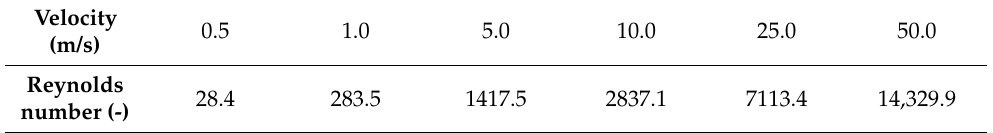
Figure 9. Assessment of the POCS pressure drop: qualitative estimation of the computational grid effects. Fluid pressure field visualization. ( a ) mesh A-Straight; and ( b ) mesh C-Straight . Table 5. Assessment of the POCS pressure drop: fluid flow Reynolds numbers.